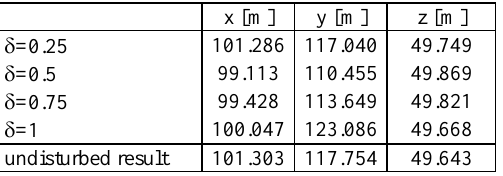
Table 1. Estimated point coordinates for different  -cuts and the accurate result from the undisturbed measurement